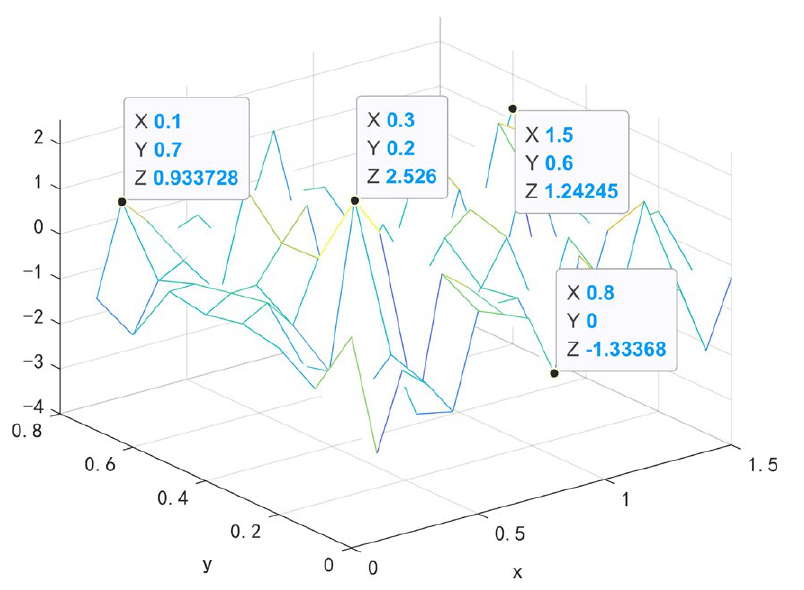
Figure 6. Original two-dimensional discrete data.